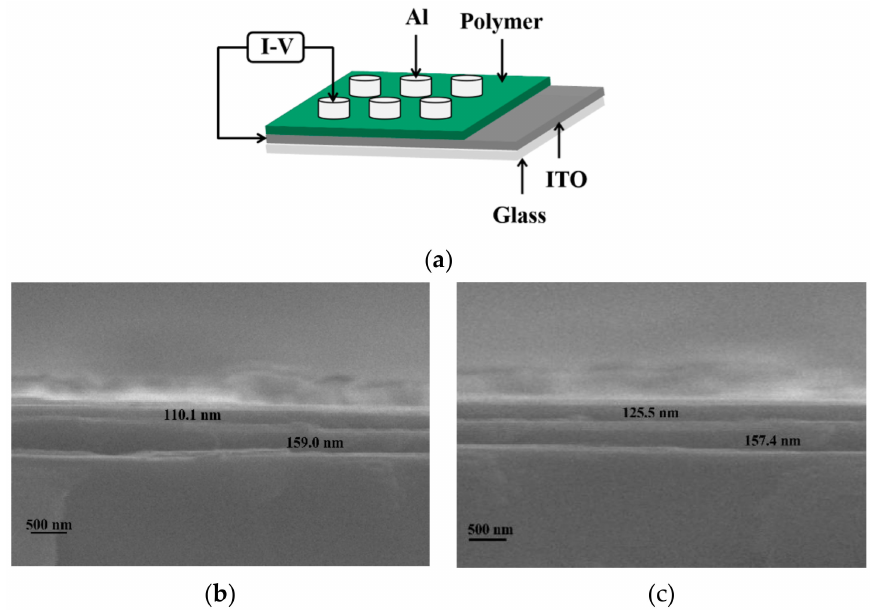
Figure 4. ( a ) The structure of the device. ( b ) The cross-sectional SEM image of the PIB film. ( c ) The cross-sectional SEM image of the PIB: SnO 2 NPs composite